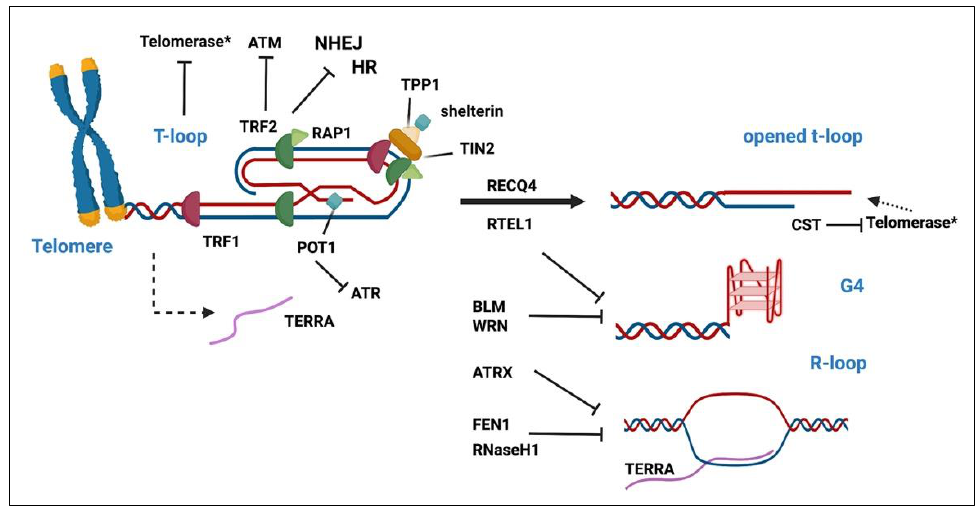
Figure 2. Telomere maintenance in mammals. Graphical representation of the mammalian telomere and the key factors involved in its maintenance. The telomere, the end of chromosome, is composed of a double-stranded DNA part, consisting of TTAGGG repeats in tandem, followed by a single 3′ overhang that invades the telomeric double-stranded DNA. This invasion generates a protective structure, called the t-loop, stabilized by the shelterin complex composed of six telomeric proteins (TRF2, TRF2, RAP1, POT1, TIN2, TPP1). TRF2 has a key function in inhibiting the activation of ATM signaling and inappropriate repair by HR and NHEJ. Once the telomere opens during the S phase, the telomerase, in telomerase-positive cells (*), can bind telomeres and add telomeric repeats. Then, the CST complex inhibits telomerase to prevent excessive telomere extension. Telomeres can also adopt unusual structures, such as G4, due to the G-rich content of the telomeric DNA sequence, or R-loop formed by the association of telomeric DNA with TERRA, the non-coding telomeric transcript of the telomere. These structures must be dismantled by the indicated proteins for replication to continue.